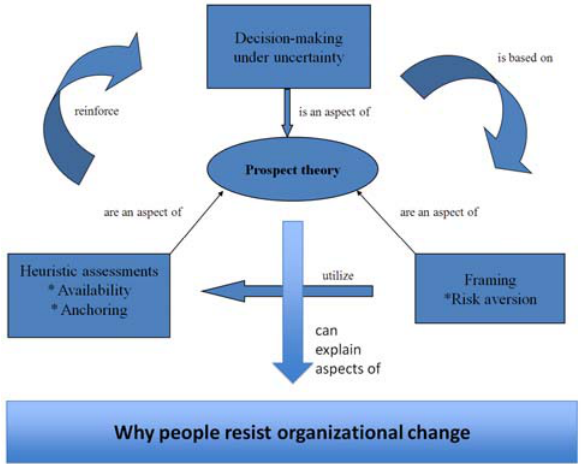
Fig. 1. Prospect theory as an explanation of why people resist organizational